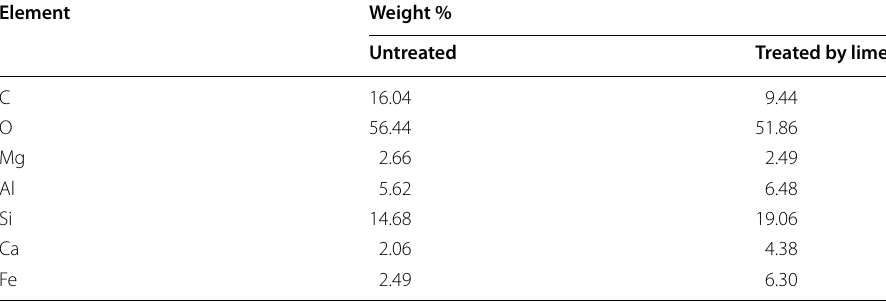
Table 10 Chemical composition of untreated and treated soil SE Element Weight % Untreated Treated by lime C